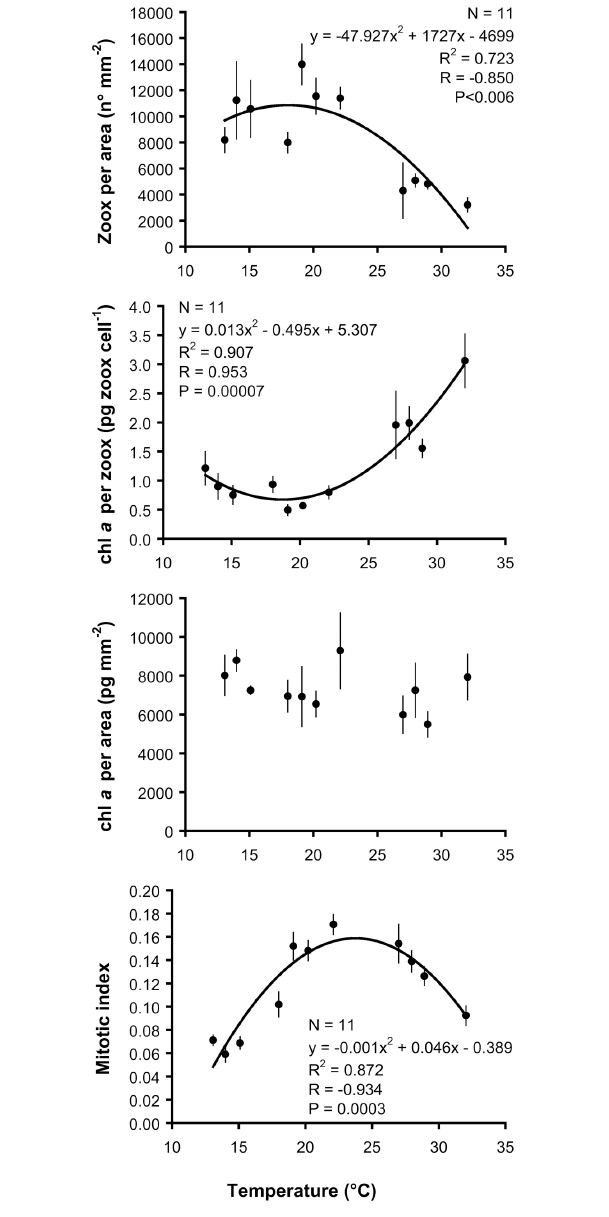
FIGURE 5 | Balanophyllia europaea . Regression and correlation analysis between zooxanthellae number per area, chl a per zooxanthellae cell, chl a per area, mitotic index, and temperature using a quadratic function model. Error bars are standard errors. N number of temperature